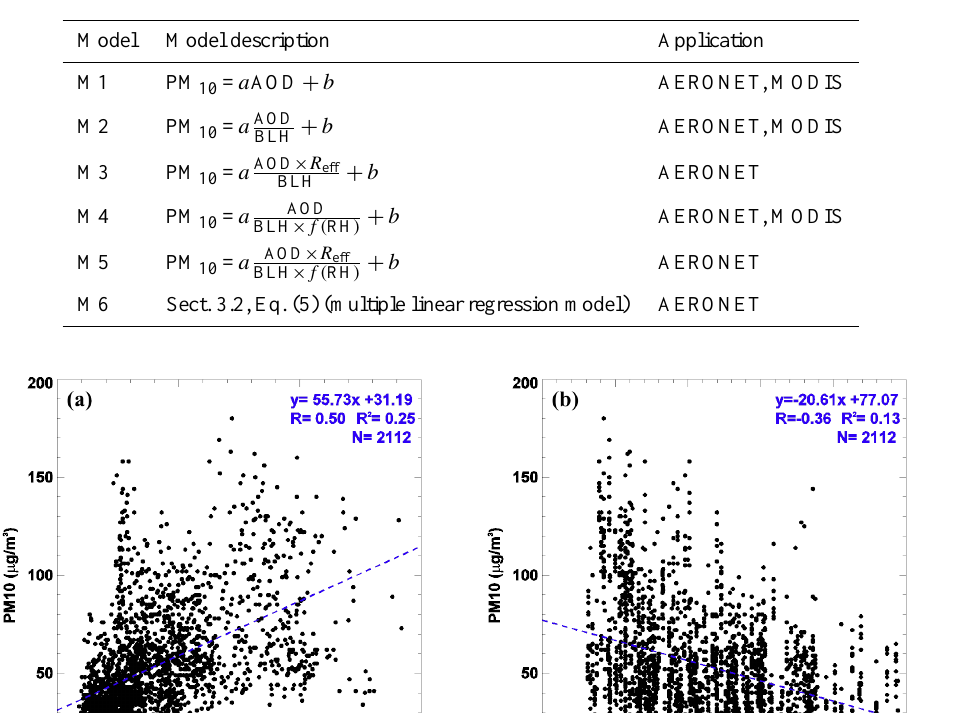
Table 3. The empirical linear models used for PM 10 estimations in this study.